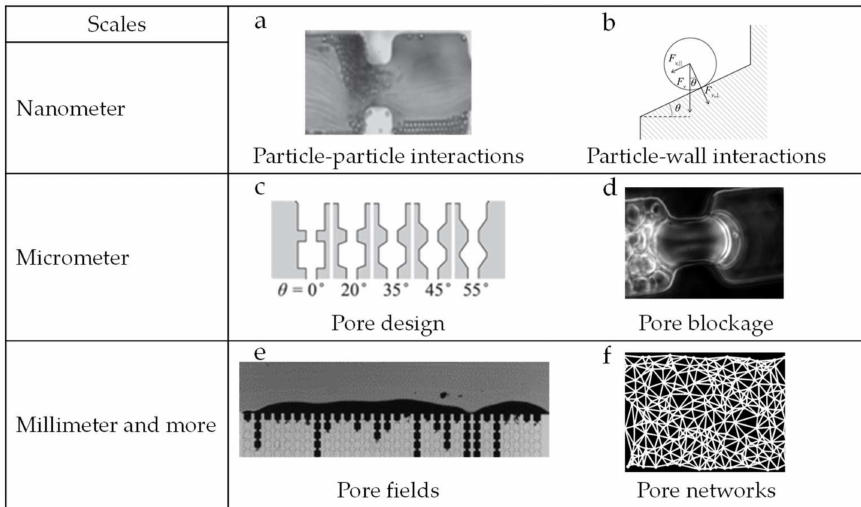
Figure 2. Examples of how microfluidic tools are applied to investigate mechanisms occurring at various scales. At nanometer scale particle–particle ( a ) and particle–wall ( b ) interactions can be studied [41]. Pore design ( c ) [41] and pore blockage ( d ) [42] are topics that can be investigated at micrometer scale, and finally at millimeter scale pore fields ( e ) [32] and pore networks ( f ) [43] have been used to study the collective behavior of particles in porous media. Images a-e have been cropped from their original work and reproduced under the Creative Commons Attribution 4.0 International License [33]. Image f has been reproduced with permission from the